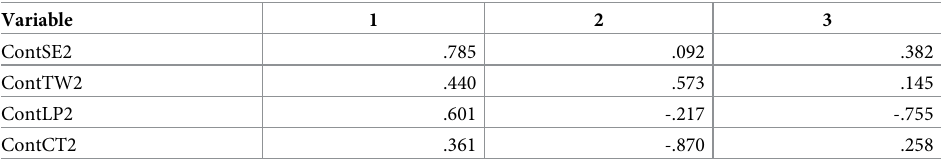
Table 13. Canonical correlation Set